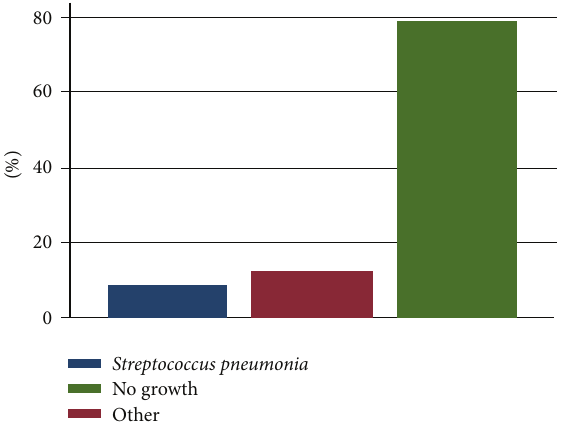
Figure 2: Bar chart of cerebrospinal fluid culture